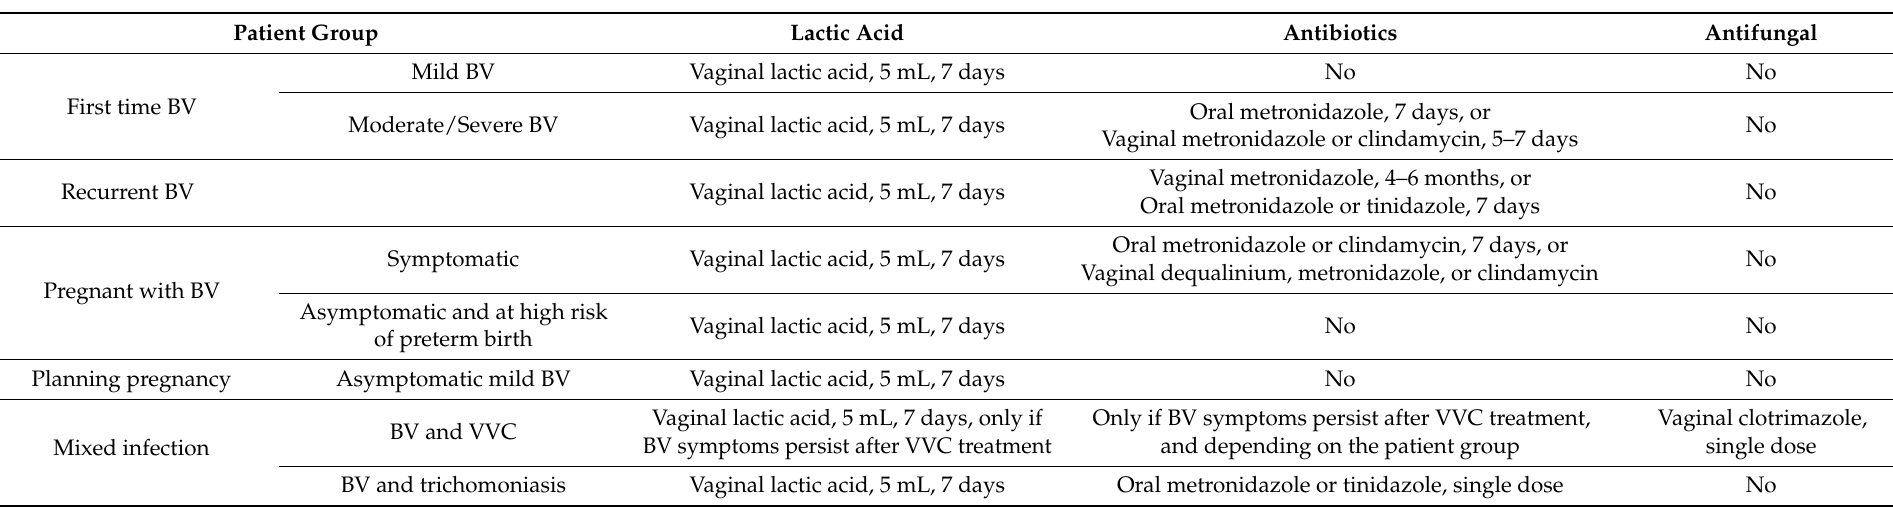
Table 2. Proposed treatments for women with bacterial vaginosis depending on the patient